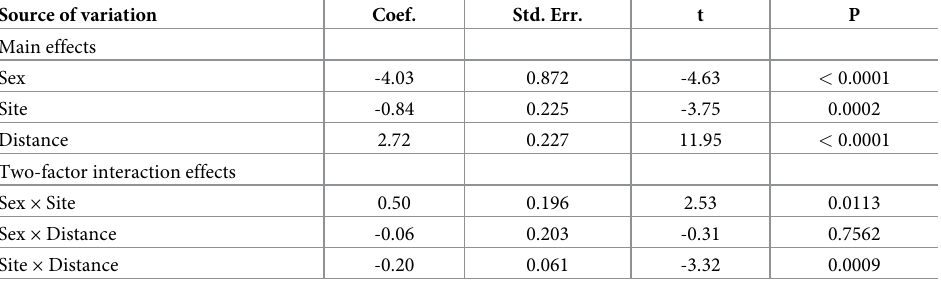
Table 4. Result of the general linear mixed model for tail-to-signal ratio (TSR) of propagated songs of the Yellow- breasted Boubou ( Laniarius atroflavus ). Main and two-factor interactions effects are presented for the following source of variation: sex (male, female), site (transect FOREST, SHRUBS, STREAM) and distance (12.5, 25, 50 and 100 m). Repeated measurements of songs of the same individuals are included as a random factor. Source of variation Coef. Std. Err.